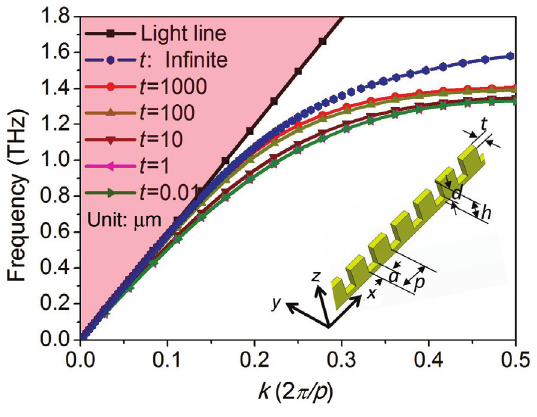
Figure 1: Dispersion curves of the spoof SPPs in plasmonic meta- material with different thickness. The black line denotes the light line, the blue line shows the dispersion curve of the corrugated metal plate with infinite thickness in the y direction, and the other lines correspond to five values of thickness: t = 1000, 100, 10, 1, and 0.01 μ m. The inset displays the corrugated metal strip with p = h = 50 μ m, d = 40 μ m, and a = 20 μ m. Reproduced from [39] with